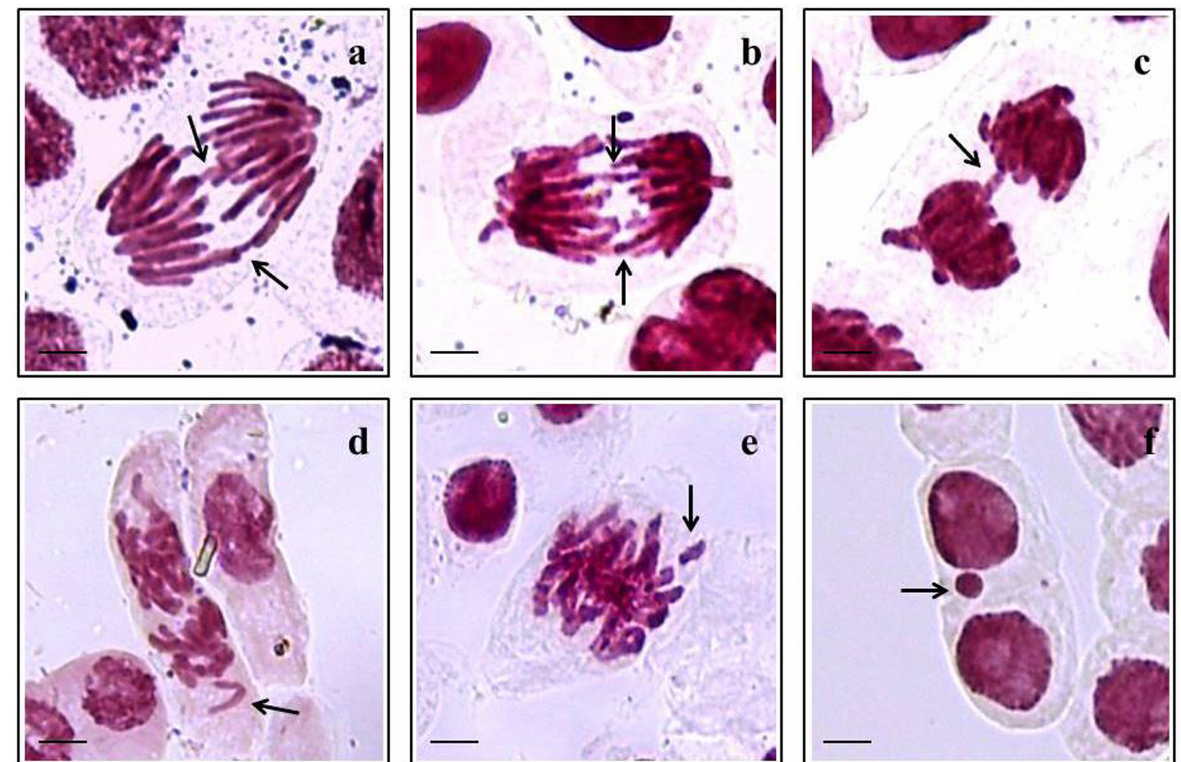
Figure 1 - Allium cepa cells submitted to the aqueous extracts of Sambucus australis . a – arrow indicating anaphasic bridge (cell treated with aqueous extract of inflorescences 0.003 g/ml, accession 1); b – arrow indicating anaphasic bridge (cell treated with glyphosate 1%); c – arrow indicating telophase with bridge (cell treated with glyphosate 1%); d – arrow indicating laggard chromosomes (cell treated with aqueous extract of inflorescences 0.012 g/ml, accession 2); e – arrows indicating breakage (cell treated with glyphosate 1%); f – arrow indicating micronucleus (cell treated with glypho + 24 hours leaves at 0.012 g/ml, accession 2). Scale =